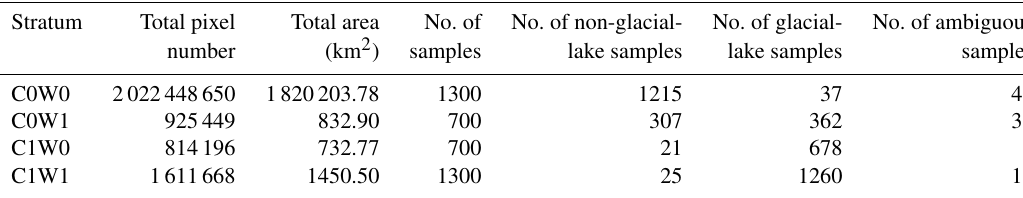
Table A6. Statistical results of stratified random